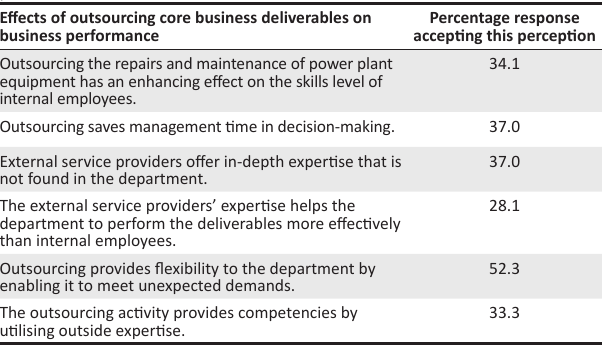
TABLE 4: Frequency of outsourcing core business deliverables in the power plant maintenance department per month. Frequency of outsourcing core business deliverables in the PPM department per month